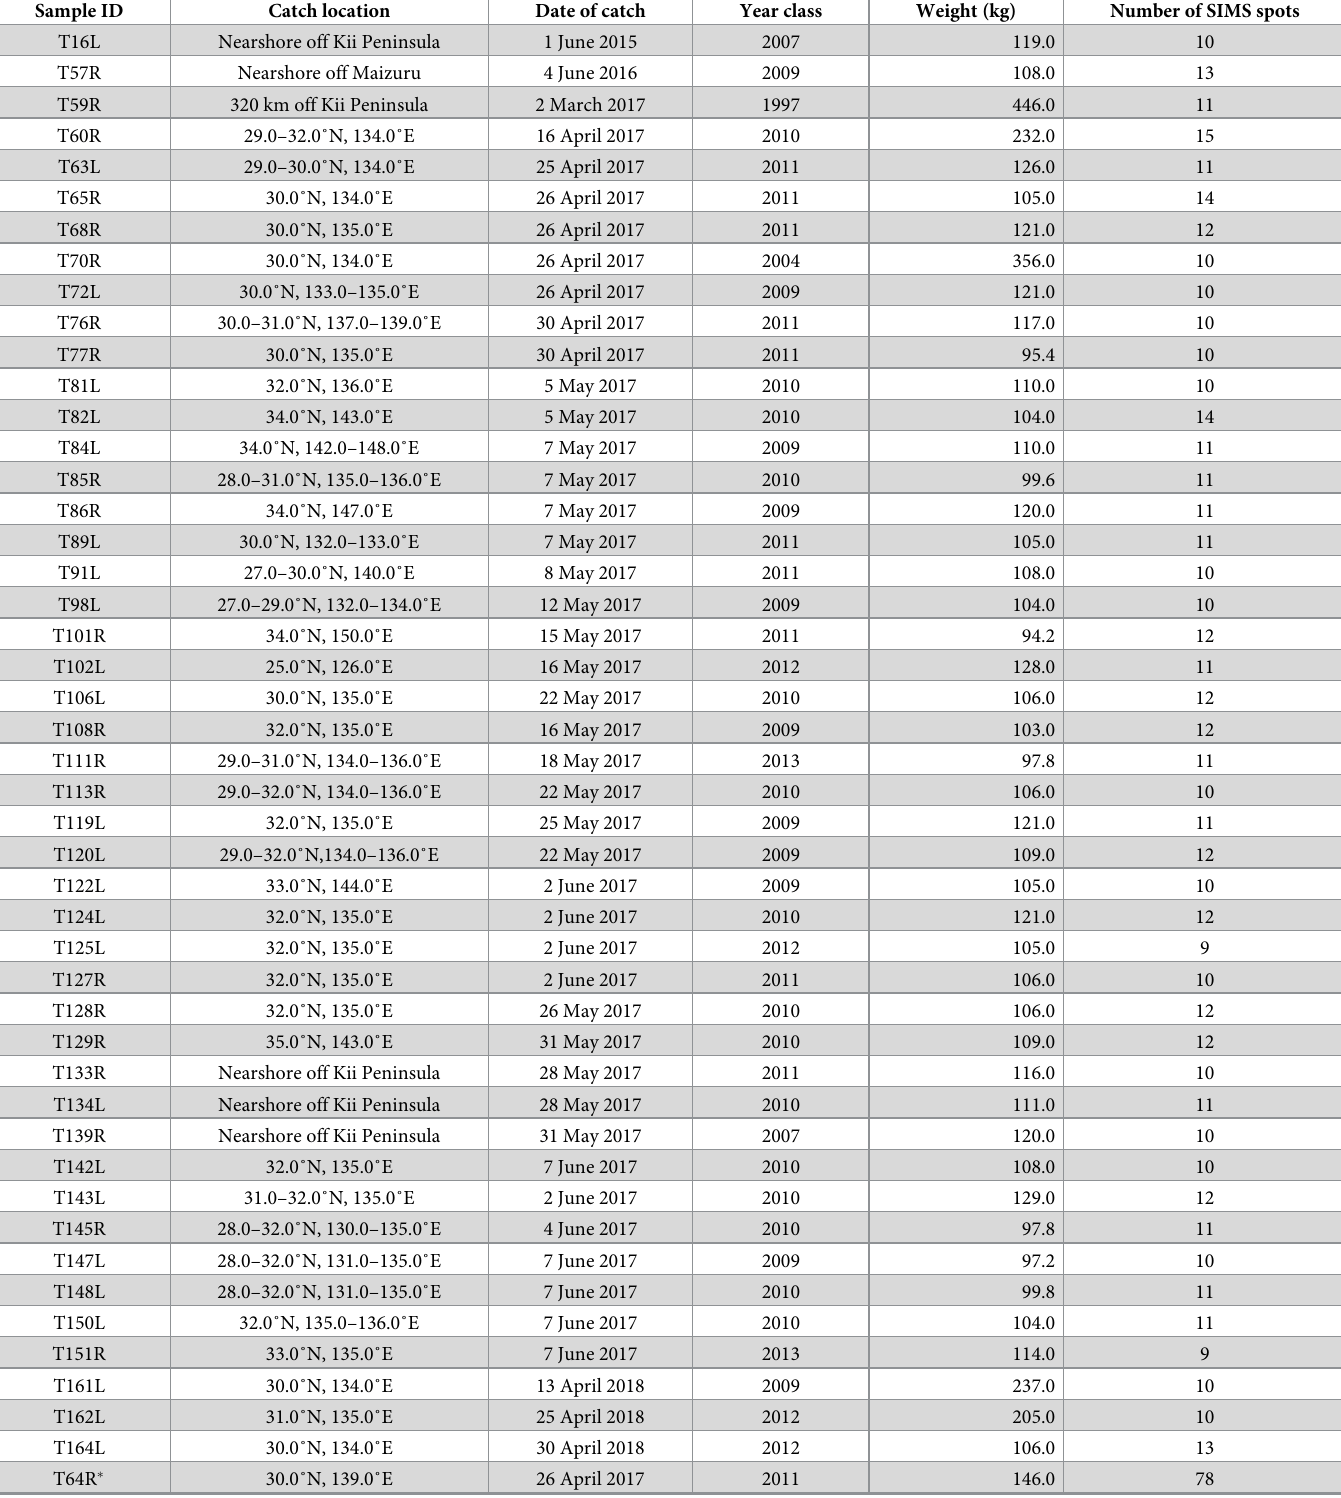
Table 1. Summary on sampling data, biological information, and δ 18 O otolith analyses of Pacific bluefin tuna